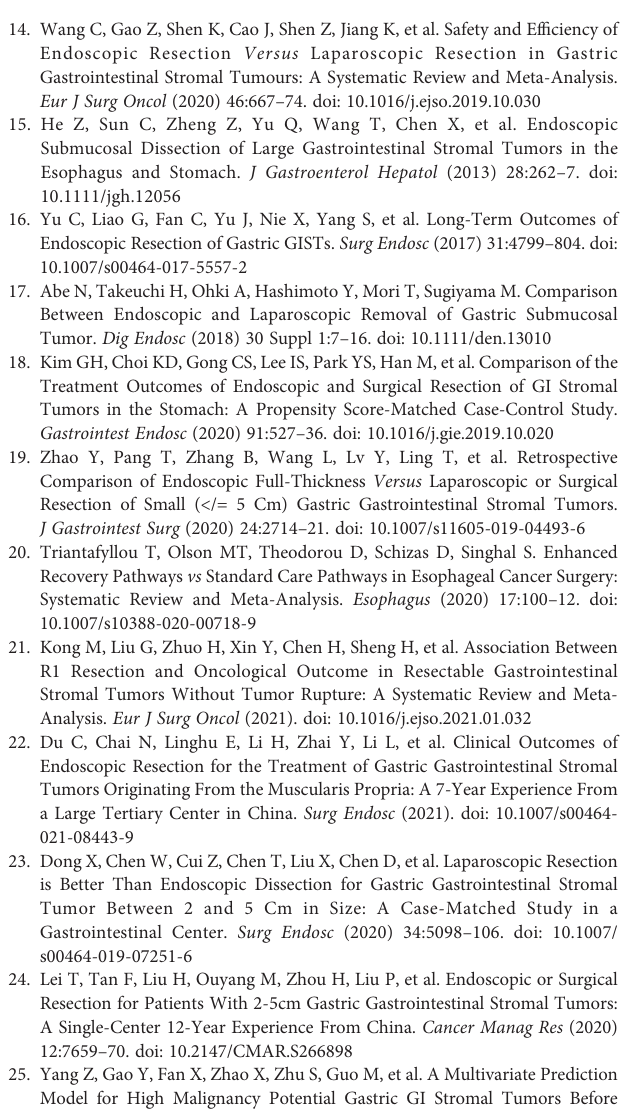
Supplementary Figure 1 | Evaluation of propensity score matching. (A) Jitter plot of individual cases; (B) Line plot of individual differences; (C) Histogram of propensity score; (D) Dot plot of standardized mean